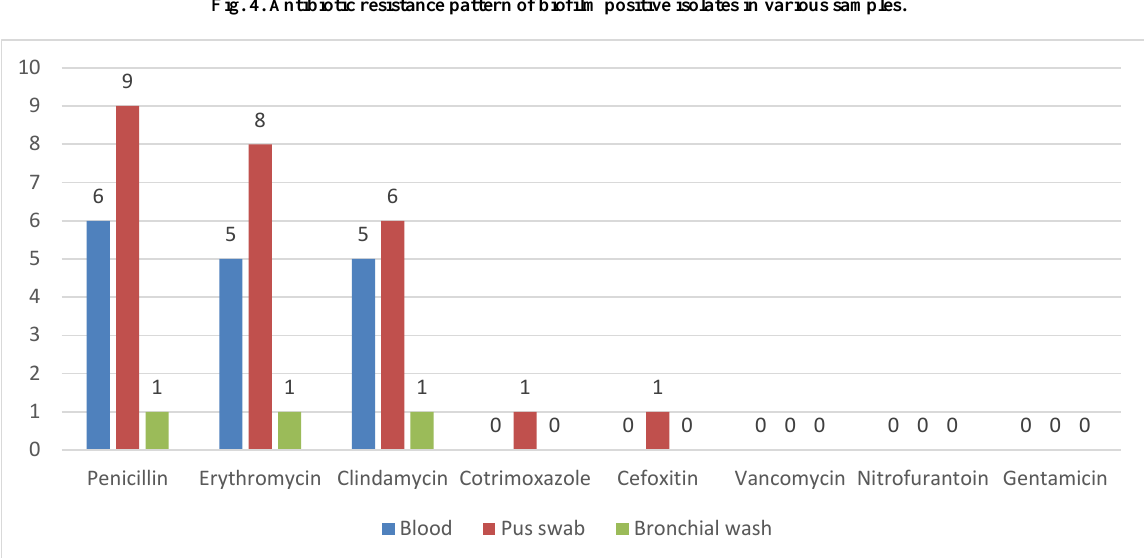
Fig. 5. Antibiotic resistance pattern of Dnase positive isolates in various